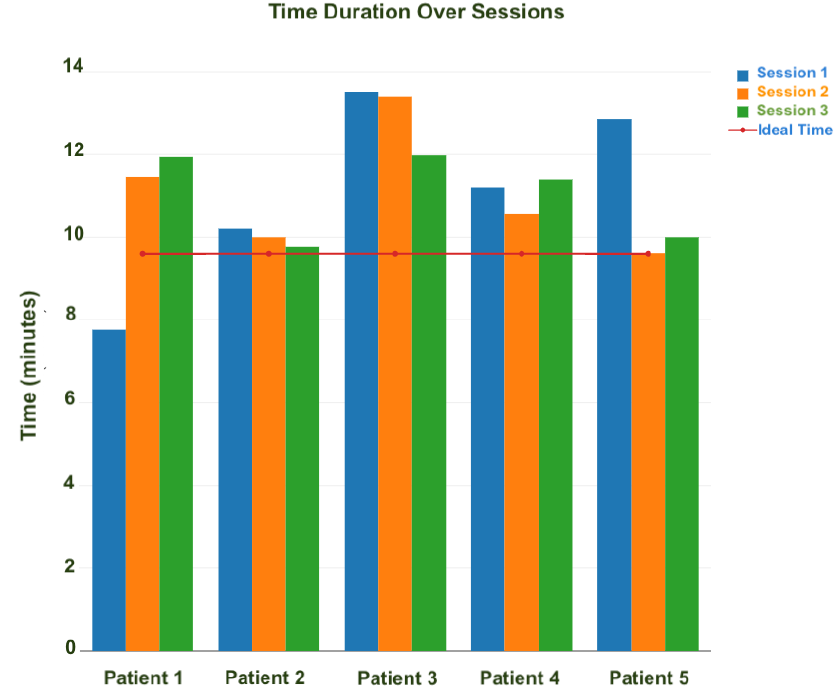
Figure 13. Total time required to finish the prescribed therapy in different sessions.